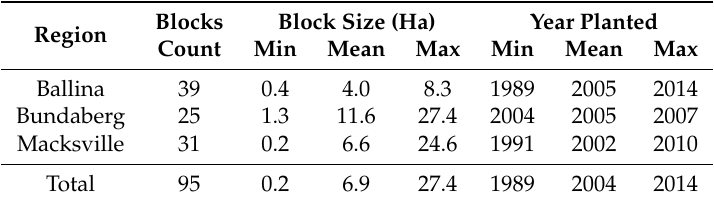
Table 1. Distribution of blocks, block sizes, and planting